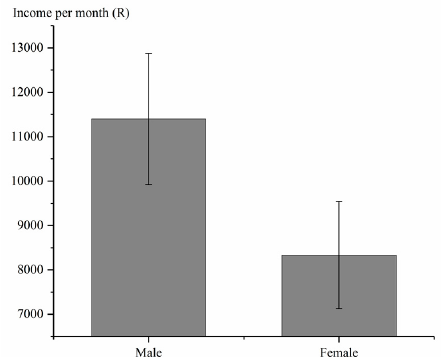
Figure 5. Correspondence between income levels and gender in the Nzhelele and Levuvhu river catchments.